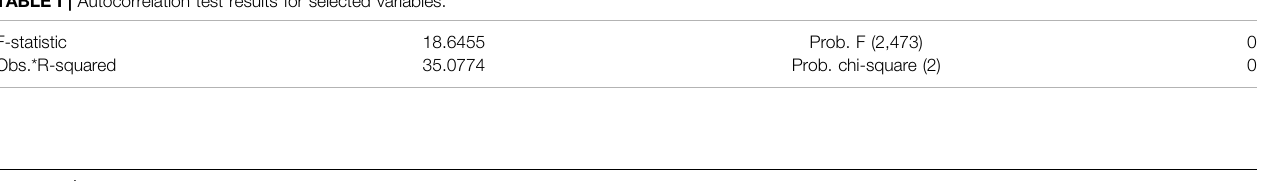
TABLE II | Heteroscedasticity test results for selected variables.